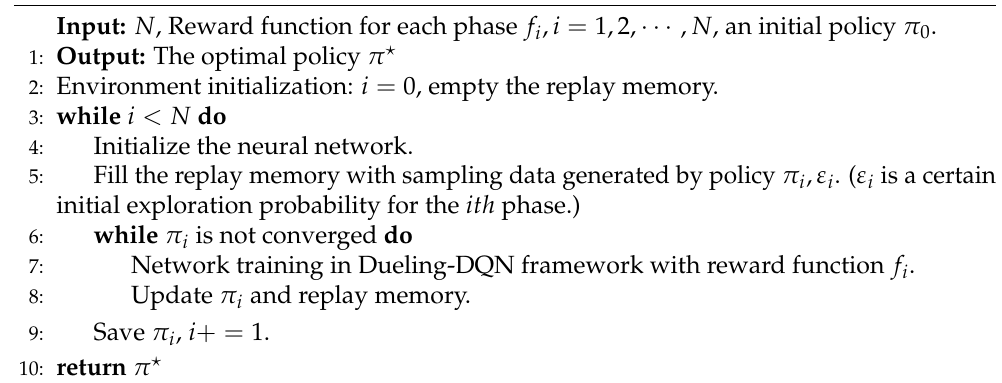
Algorithm 1 A multi-stage training framework with N sub-missions.